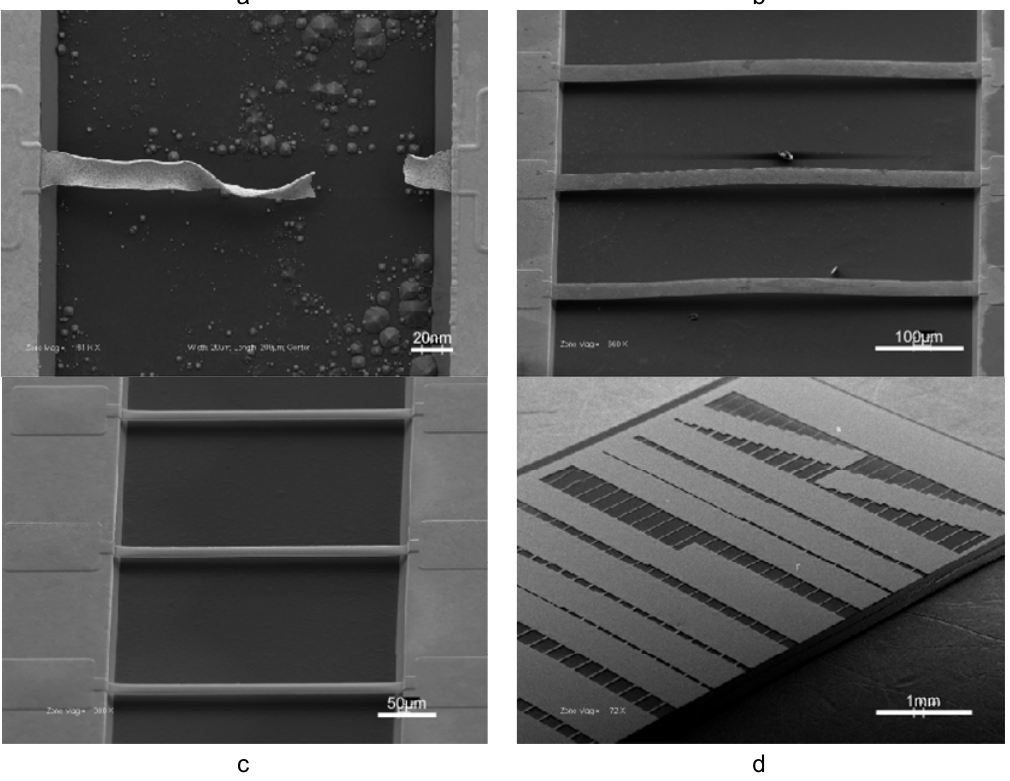
Figure 7. Illustration of fracture and remedy in np-Au: (a) freestanding doubly-clamped beams catastrophically fail during dealloying due tensile stress accumulation as a result of volume contraction; (b) rapid thermal treatment permanently buckles Au-Ag beams; (c) buckling strain offsets volume contraction and intact np-Au beams are realized; (d) a typical chip containing ~200 intact np-Au beams of various dimensions. [Reproduced with permission from Acta Mater . 2008 , 56 , 324–332. © 2008,